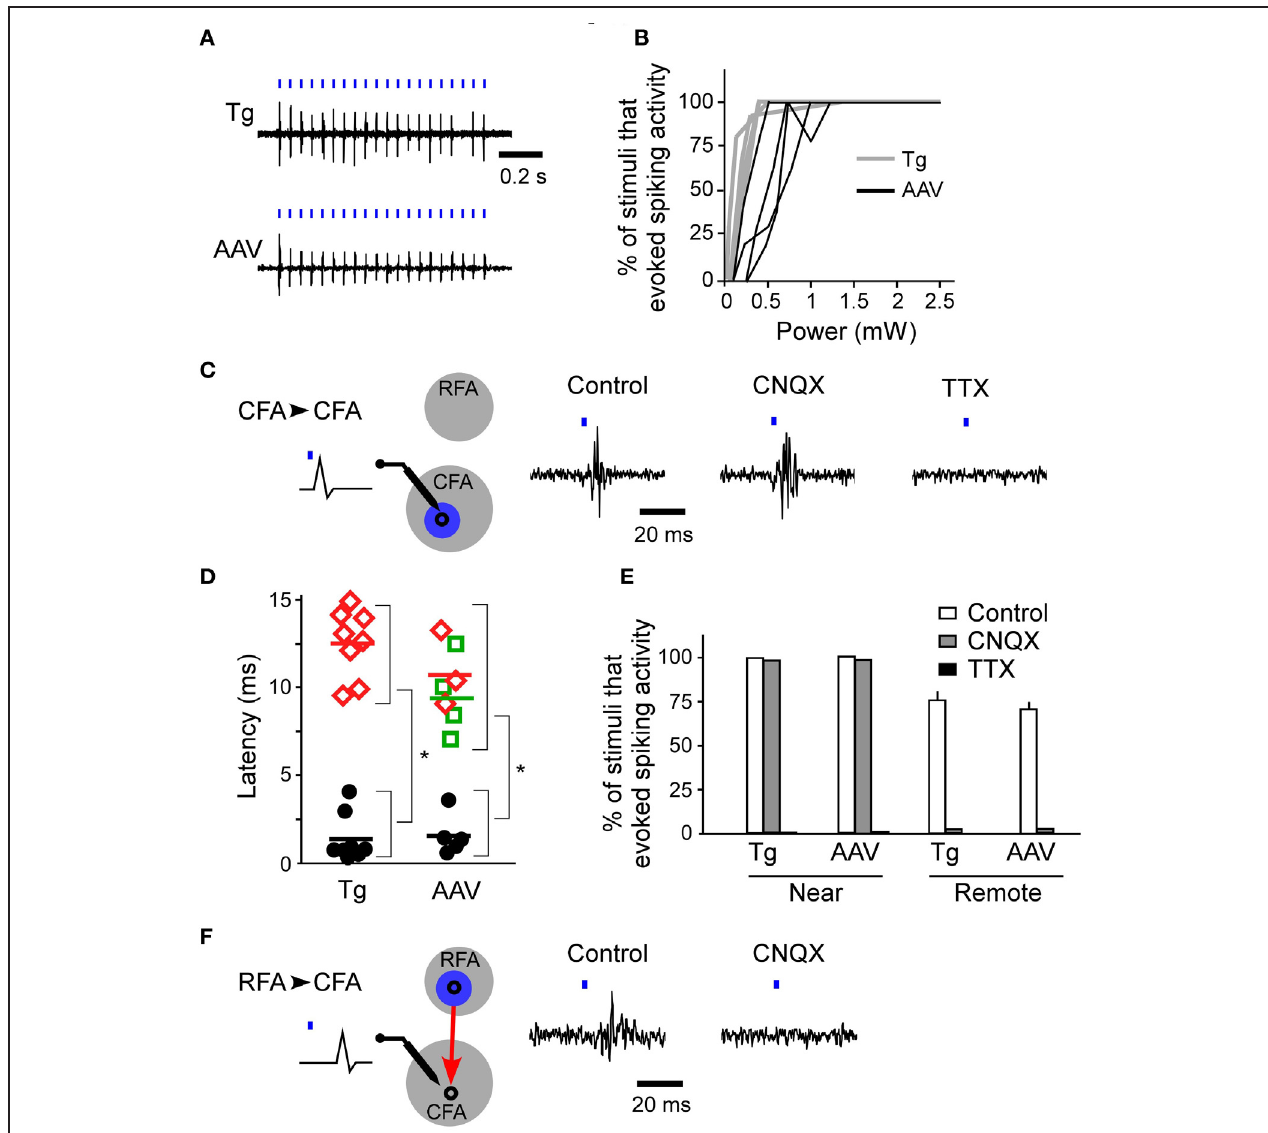
FIGURE 3 | Firing activities evoked by ChR2 photostimulation of the RFA and CFA. (A) Representative spiking activities induced by photostimulation of the CFA in the ChR2 Tg and AAV-ChR2 mice. Both traces were recorded in L5 of the CFA. The horizontal distances between the photostimulation points and the recording sites were approximately 200 µ m. The blue bars represent the photostimuli (10ms durations at a frequency of 20Hz). The laser intensity was 2.5mW. (B) Relationship between the laser power and the percentage of trials in which firing activities were evoked near the photostimulation points (gray, six sites in four ChR2 Tg mice; black, four sites in three AAV-ChR2 mice). The duration of photostimulation was 10ms. (C) Left, A schematic of the experimental arrangement for photostimulation (blue) of the CFA (gray) with simultaneous electrical recording in the CFA. CFA photostimulation directly evoked firing of neurons in the CFA. Right, Representative data showing spike activities recorded in the CFA when the CFA was photostimulated in control conditions, upon CNQX application, and upon TTX application. The data were obtained from the same recording site and the same photostimulation site in a ChR2 Tg mouse. The duration of photostimulation was 2ms. (D) Latencies of evoked spiking activities. Black circles indicate the electrical recordings that were made near the